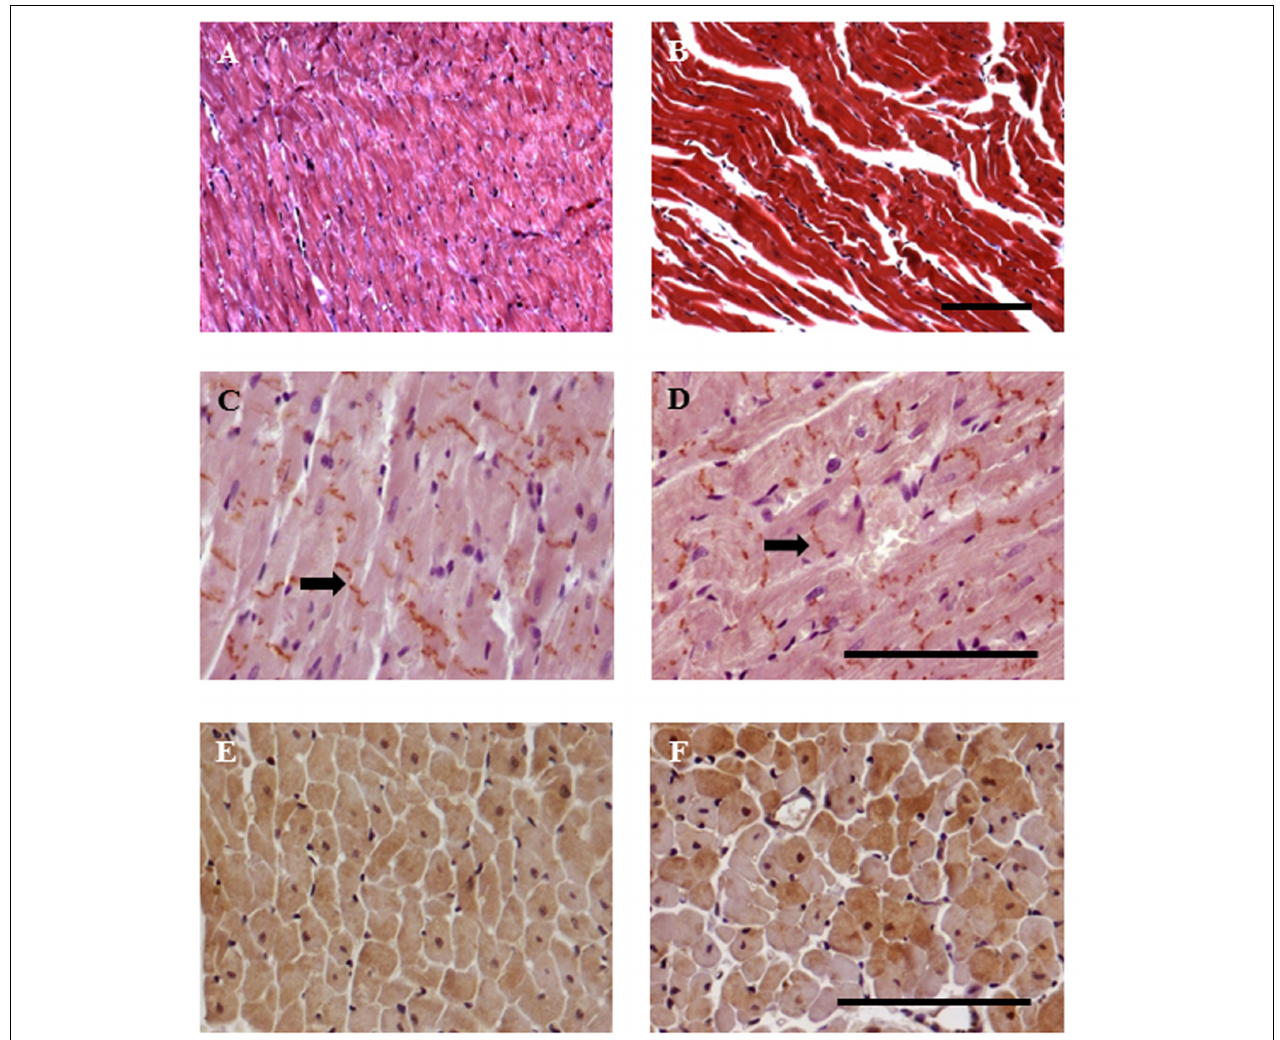
FIGURE 5 | Representative images of histology and immunohistochemistry of the effect of cisplatin treatment on rat hearts. Rats were injected intraperitoneally for 5 weeks with saline (0.9% NaCl, left column) or cisplatin (3 mg/kg week − 1 , right column). Histological samples embedded in paraffin and stained with Masson’s trichrome (A,B) . Samples processed for immunohistochemistry with anti connexin-43 antibody (black arrows) (C,D) and with anti eNOS (E,F) . Heterogenicity in fiber staining is clearly seen. Bar: 100 µ